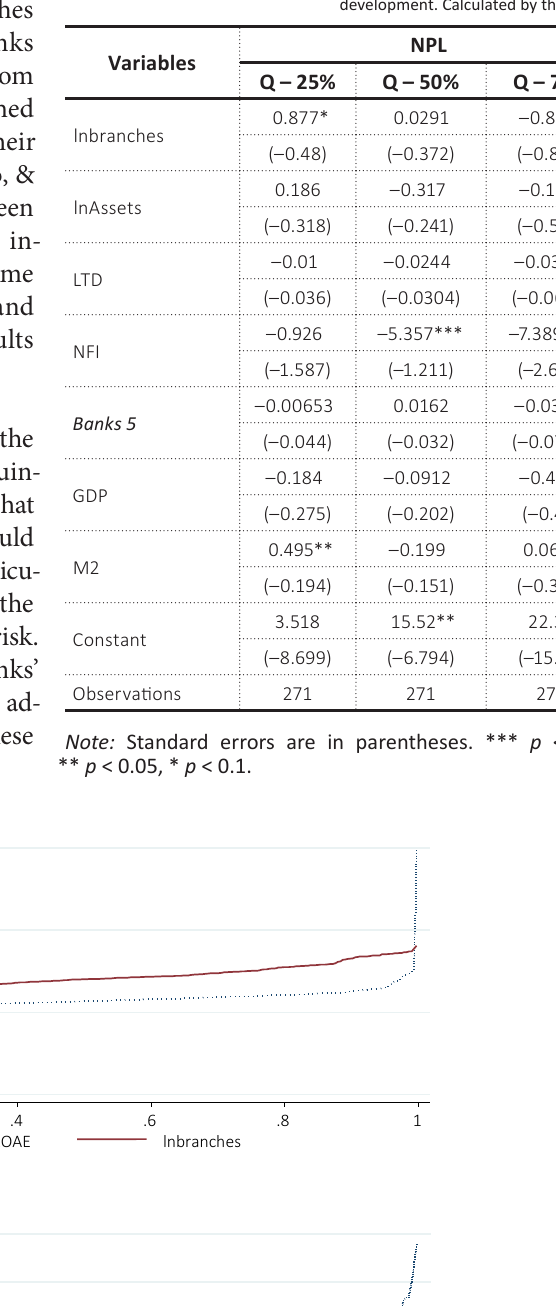
Table 6. Quintile estimation results for M2.2